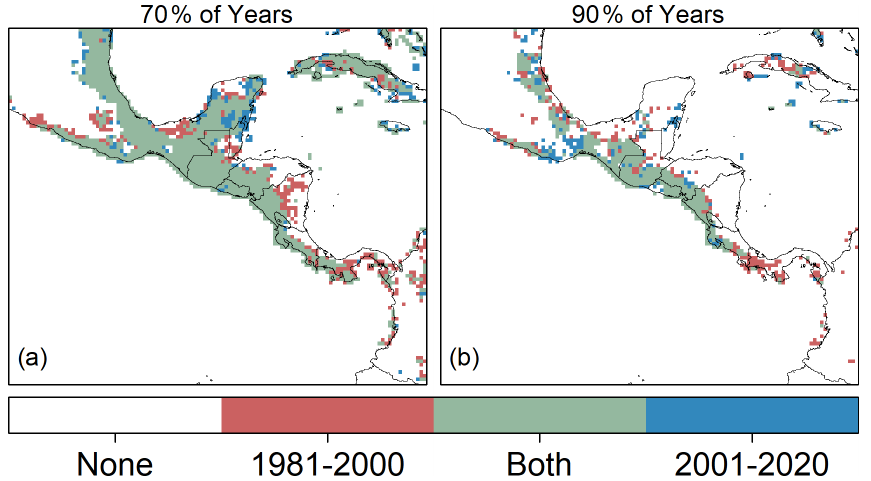
Figure 10. Pixels with an MSD by varying the original definition so that a cell must have an MSD in at least (a) 70% of years and (b) 90% of